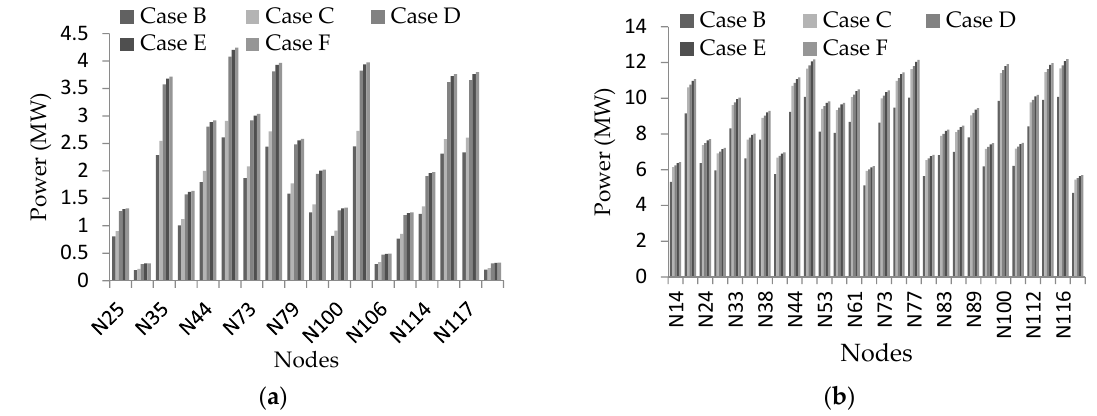
Figure 7. Variable renewable energy sources (vRES) outputs by node. ( a ) Solar power outputs by node ( b ) Wind power outputs by node.